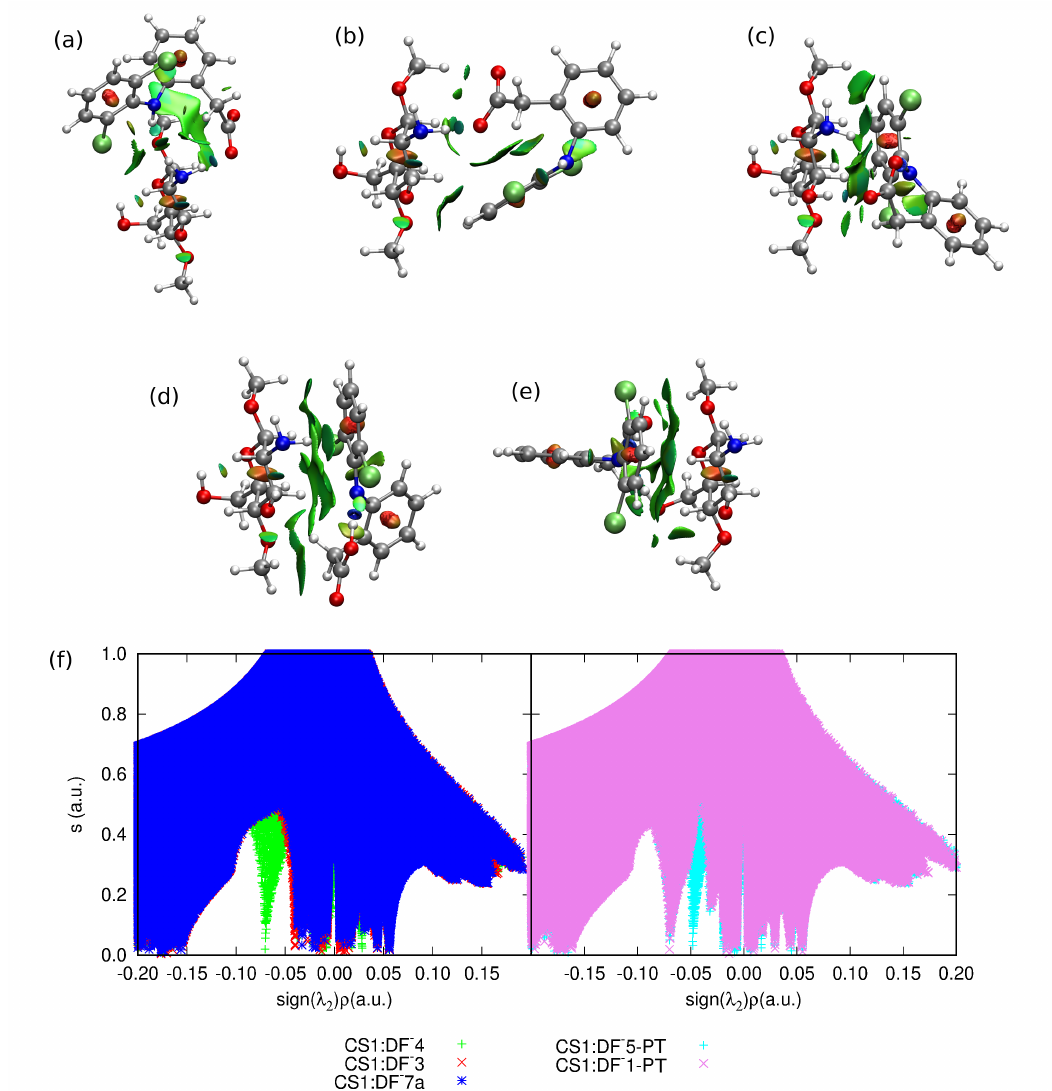
Figure 7. NCIPLOT of the most stable structures of chitozan unit interacting with DF − : ( a ) CS1:DF − 3 , ( b ) CS1:DF − 7a , ( c ) CS1:DF − 4 , the weakest attraction for proton-transfer structures: ( d ) CS1:DF − 5-PT , ( e ) CS1:DF − 1-PT and ( f ) the NCI relation between the reduced gradient, s and the sign of the second eigenvalue, λ 2 , of the electron-density Hessian. Atom colors: chlorine—lime green, oxygen—red, nitrogen—cobalt blue, carbon—silver, hydrogen—white. PT denotes the proton